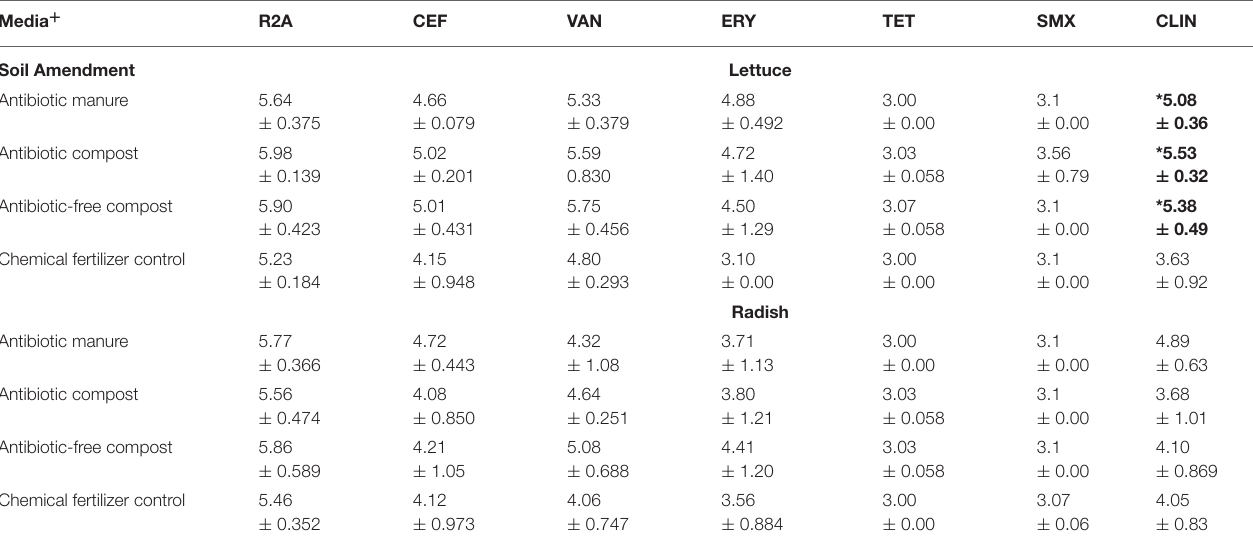
TABLE 1 | Effect of amendments on lettuce and radish heterotrophic plate counts (HPCs) determined on R2A media with and without indicated antibiotics ∧ . Media + R2A CEF VAN ERY TET SMX CLIN Soil Amendment Lettuce Antibiotic